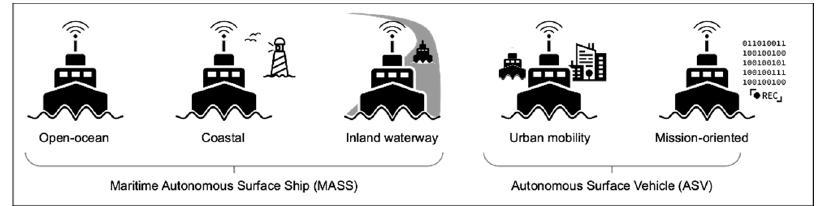
Figure 1. Categories of MASS and ASVs.